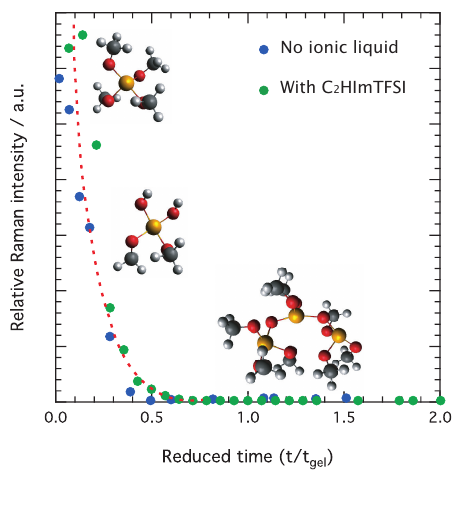
Figure 3. Time evolution of the Raman intensity associated to the symmetric Si–O–Si stretching in TMOS (644 cm − 1 ) for the solutions containing no ionic liquid and 0.05 mole ratio towards TMOS of C HImTFSI. A reduced time scale is used in the x -axis. 2